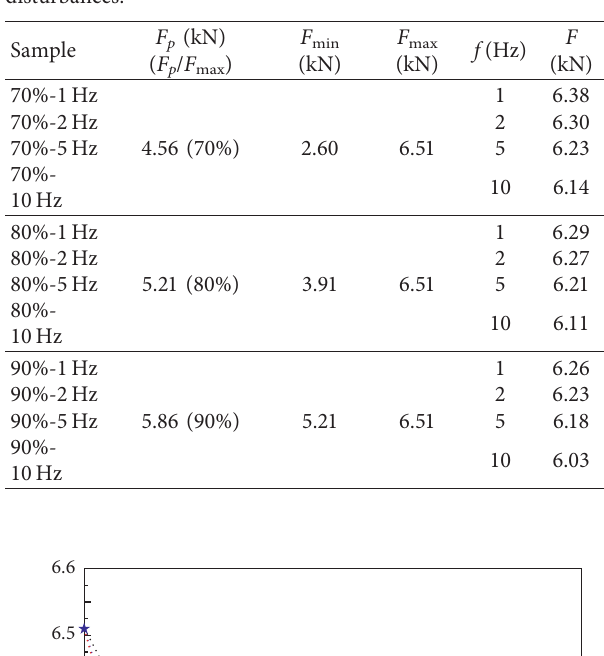
Table 2: The results under different prestatic loads and dynamic disturbances.